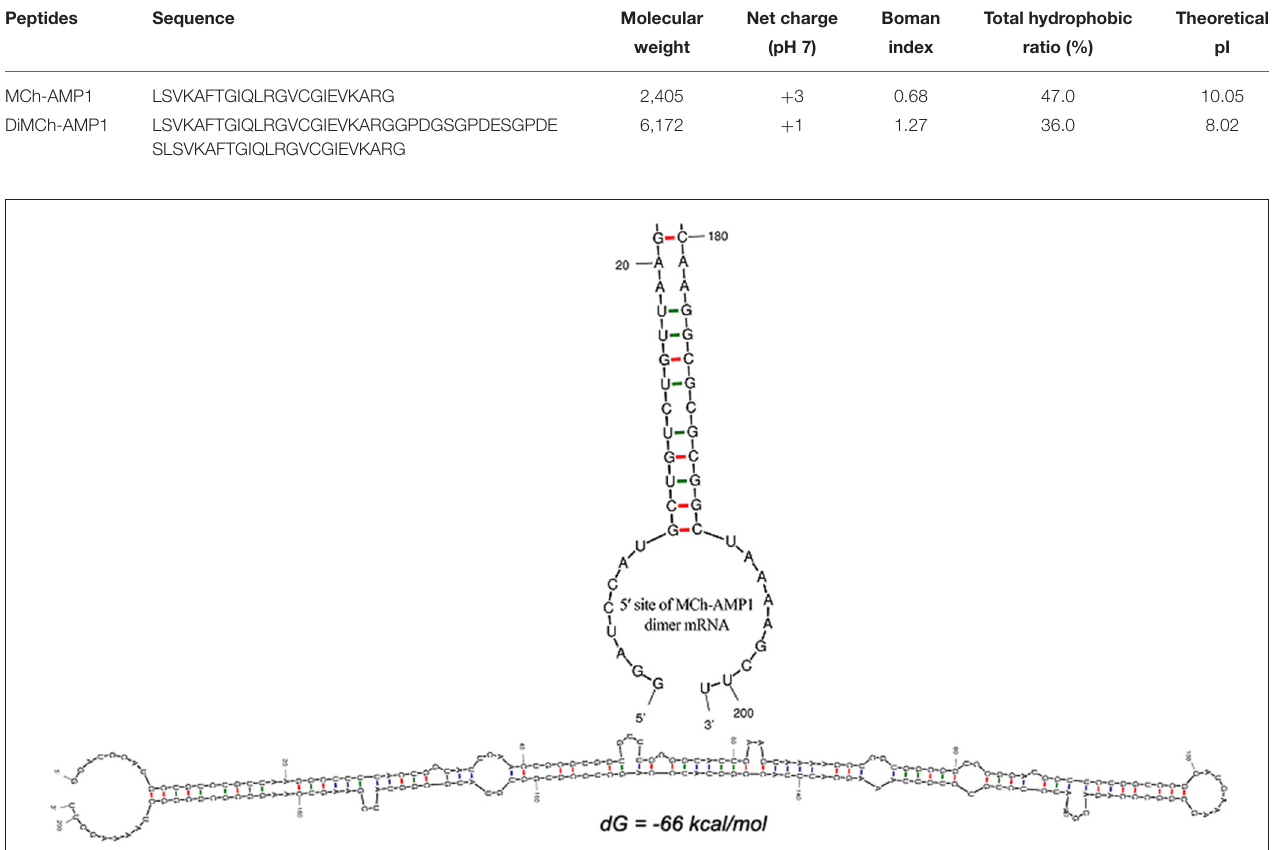
Candida and Aspergillus species, respectively. The